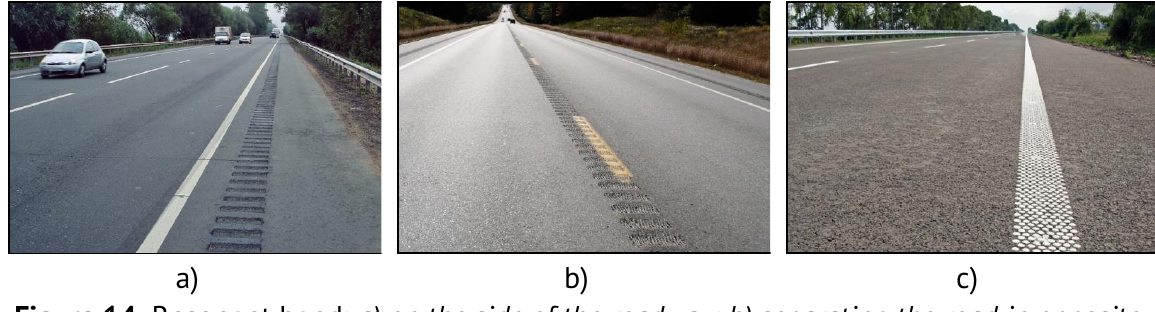
Figure 14. Resonant band: a) on the side of the roadway; b) separating the road in opposite directions; c) Structural thermoplastic or cold